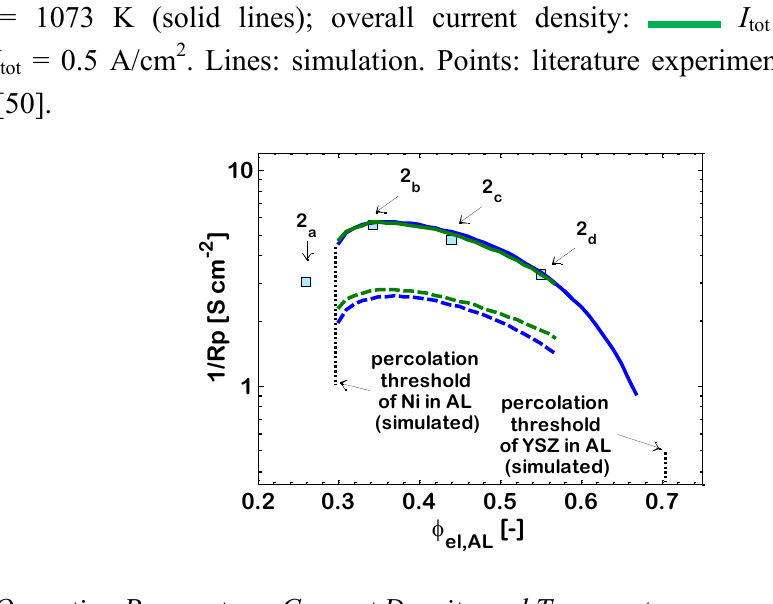
= 1 A/cm 2 ; and tot , 2 , 2 a b c